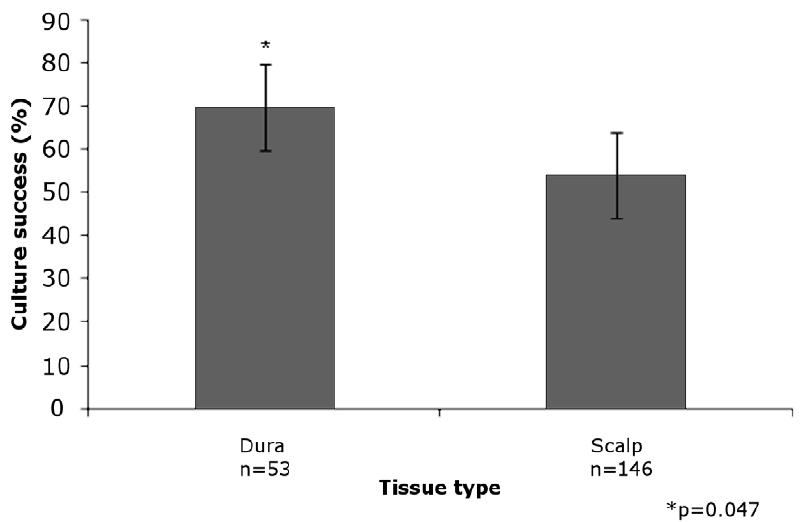
Figure 2. Percentage of successful growth in dura (n=53) vs. scalp (n=146) samples. Sample of 146 scalp and 53 dural specimens. The odds of successful culture in dura were nearly 2-fold compared to scalp.